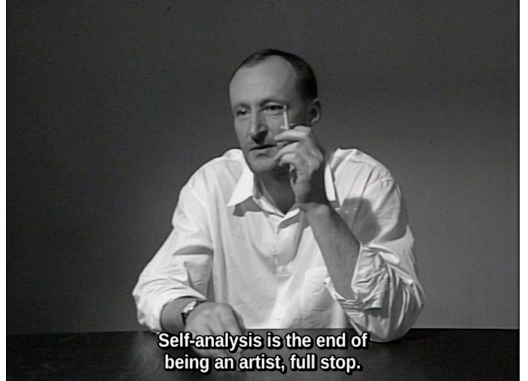
Figure 11. Jef Cornelis, broadcasted in December 1990 on the Flemish Broadcasting Company (BRT). ©Jan Vercruysse Foundation and Argos. Reprinted with permission from Jan Vercruysse Foundation and